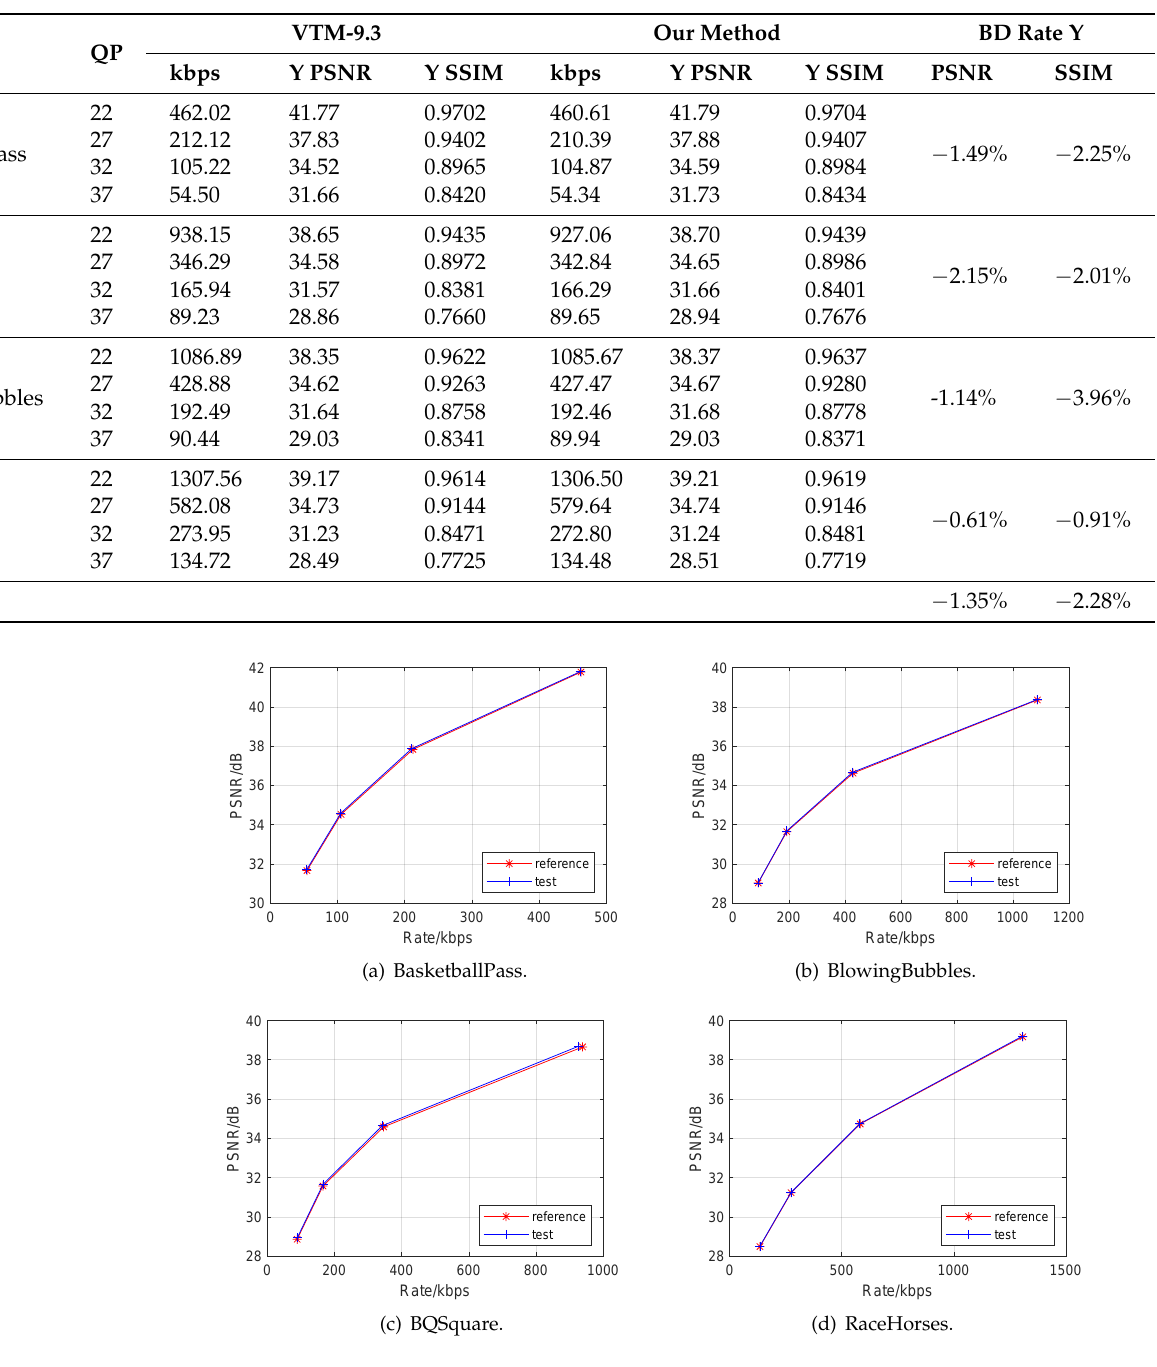
Figure 8. RD curves of class D video sequences under